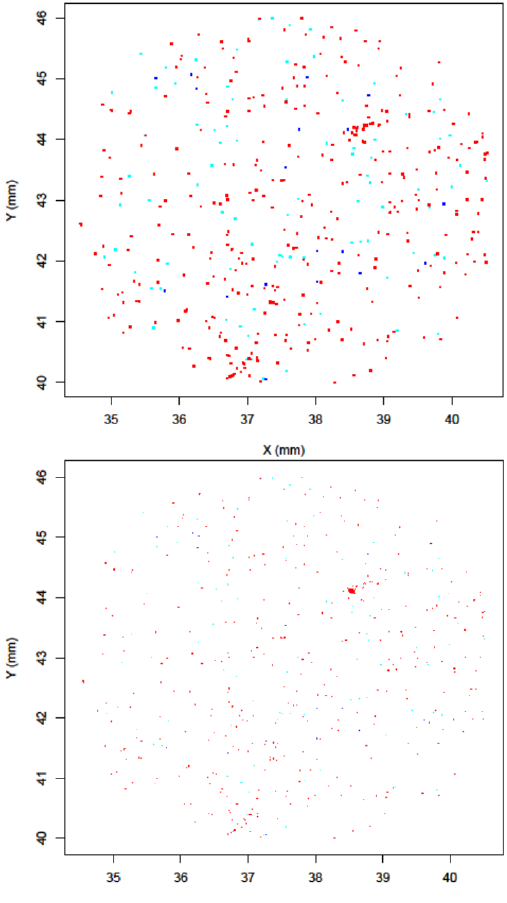
Figure 3: Inclusions with equally sized points (top) and with ellipses (bottom). The elliptic presentation reveals the actual size of the inclusions.